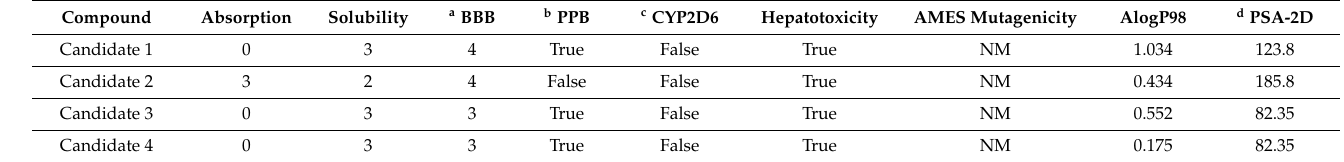
Table 4. In silico ADMET profile and mutagenic prediction of the identified candidate compounds.